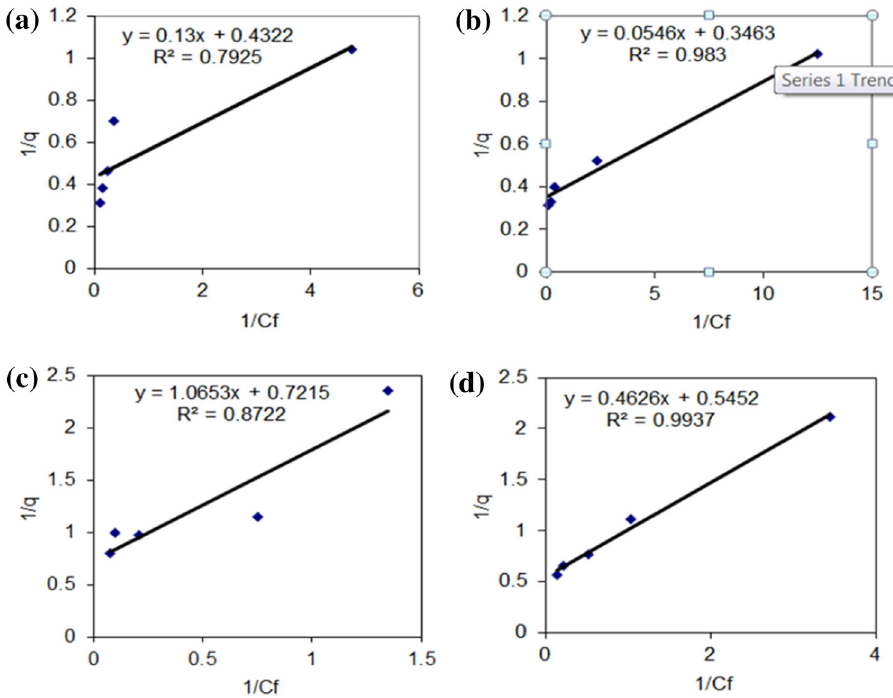
Fig. 8 Langmuir isotherms for metal removal ( a Cd on natural biosorbent; b Cd on treated biosorbent; c Zn on natural biosorbent; d Zn on treated